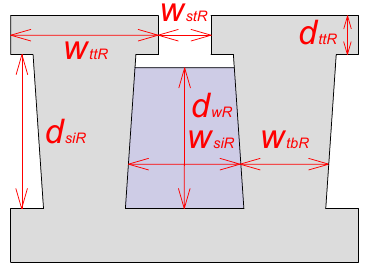
Figure 2. Rectangular machine stator slot